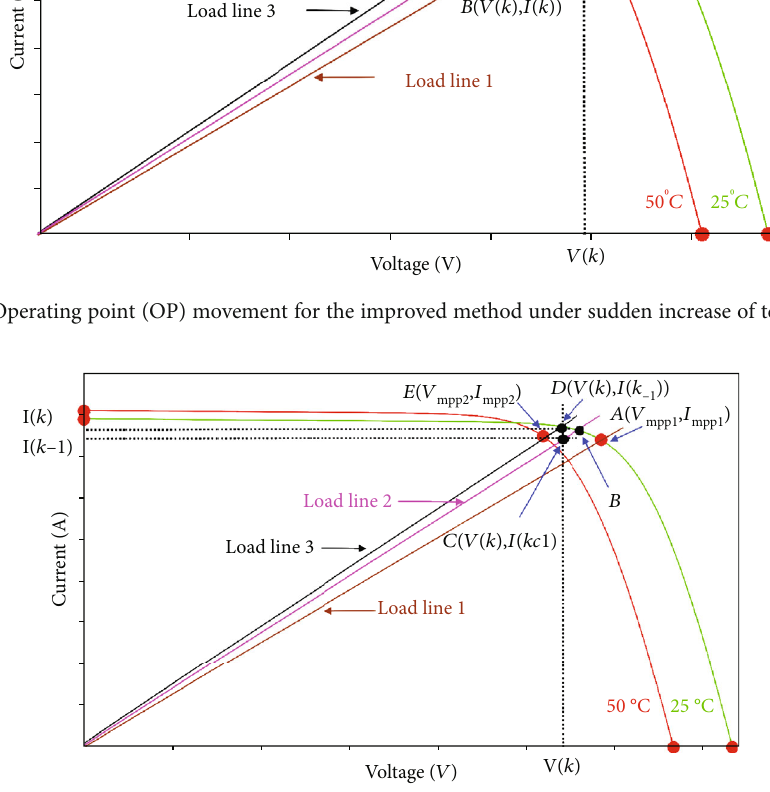
Figure 11: Operating point (OP) movement for the improved method under sudden decrease of